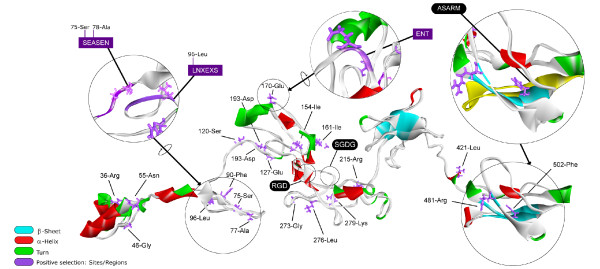
Tertiary structure of MEPE and the positive selected sites. The sites showing positive selection in at least two different analyses (purple sticks, three letters amino acid code) and the sites clustered showing positive selection in at least one analysis (close up circles, one letter amino acid code). The principal domains, RGD, SGDG and ASARM are also expanded and circled, as are the three "new" motifs (SEASEN, LNXEXS and ENT) showing positive selection. The secondary structure obtained is defined according to the code of colors described in the picture.